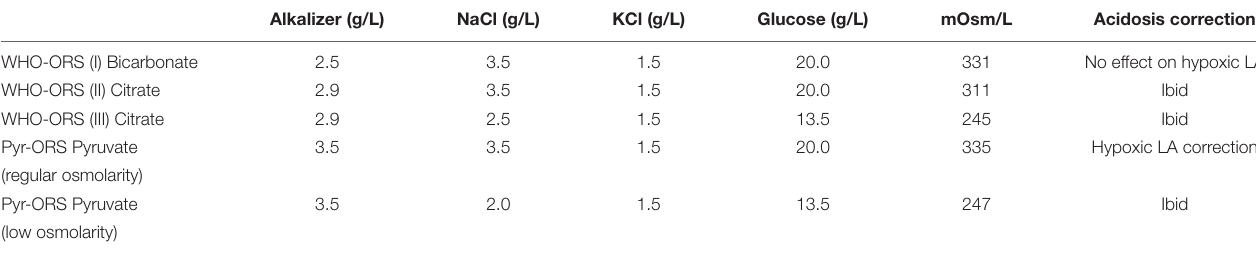
TABLE 1 | Compositions of oral rehydration